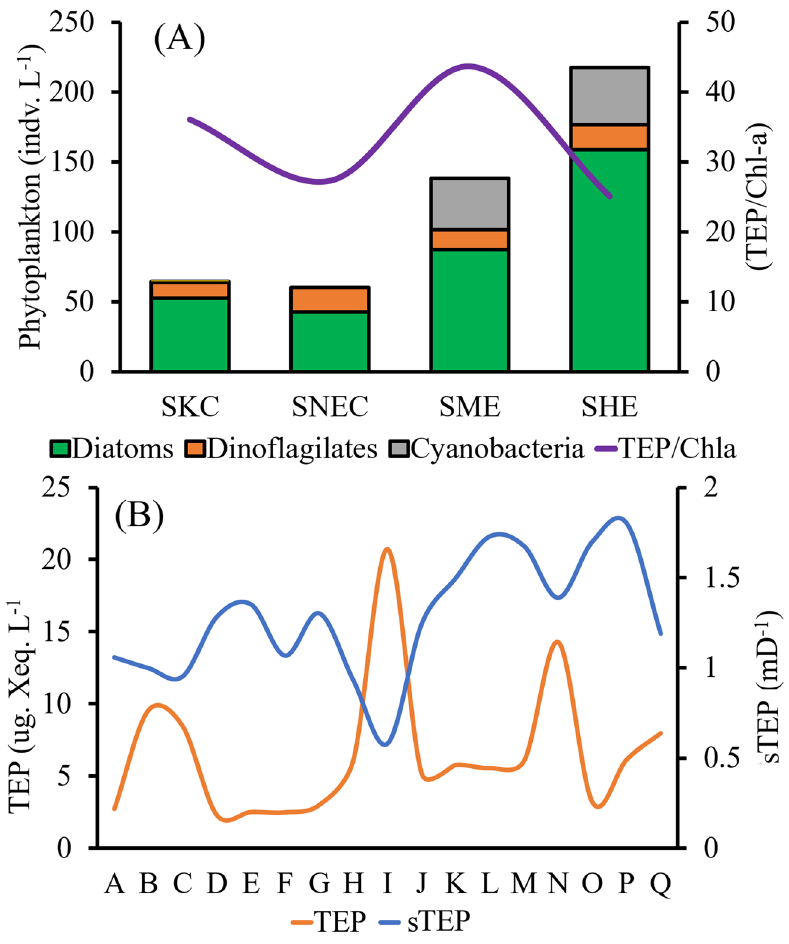
Figure 9. Average phytoplankton assemblages and patterns of TEP/Chl -a ratios ( A ) and a comparative line graph of TEP concentrations and TEPs ( B ) in the